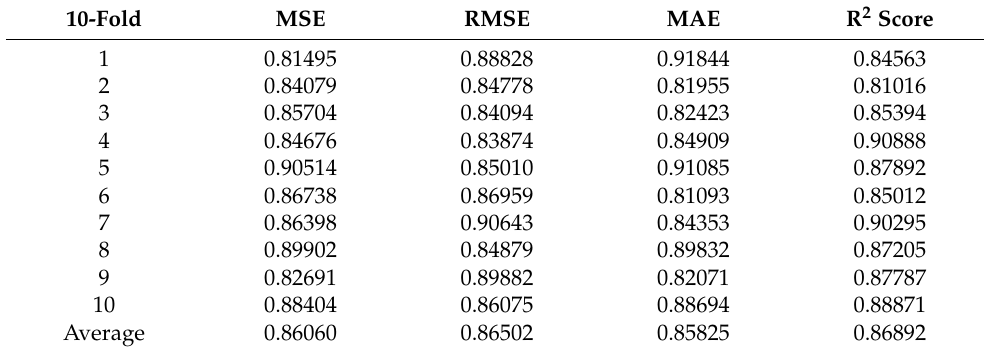
Table 11. Results for GPR.